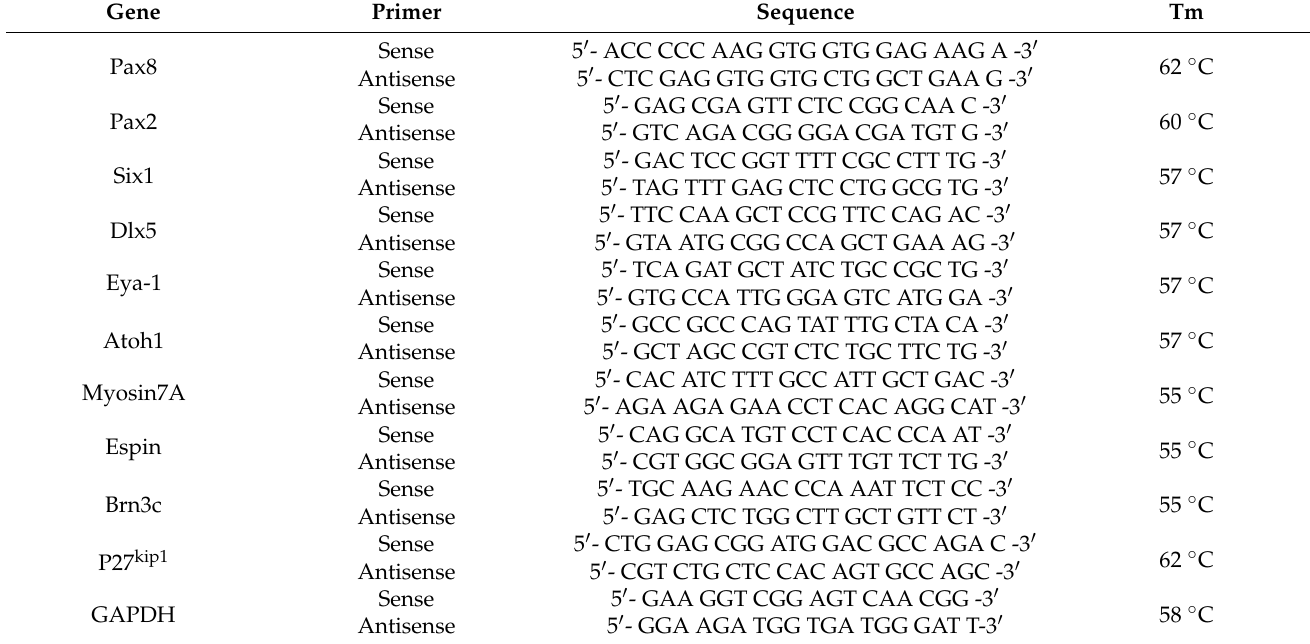
Table 2. Primers of RT-PCR for marker genes specific for otic progenitors and hair